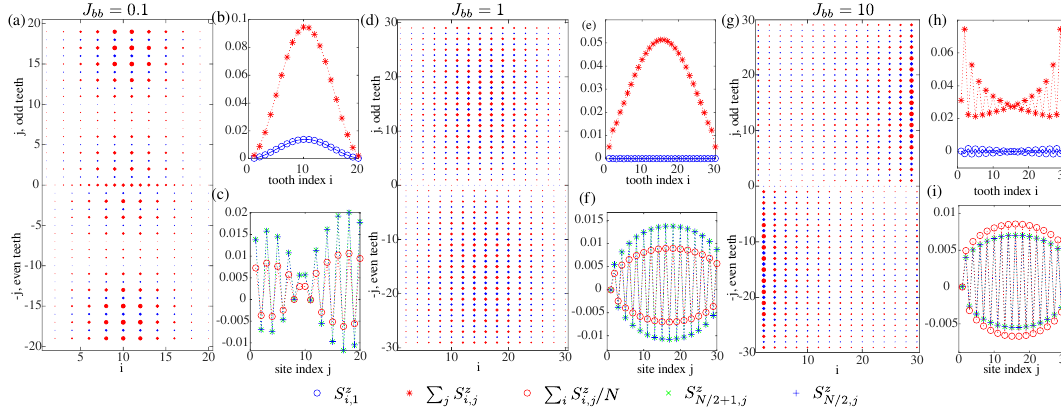
Figure 11: (Color online) Local magnetization profile on combs with even L , N for = 0.1 and L = N = 20; three different values of backbone interaction: (a)-(c) J bb = 1 and L = N = 30; (g)-(i) J = 10 and L = N = 30 . In (a),(d),(g) the (d)-(f) J bb bb comb is unfolded as in Fig.9; backbone sites are placed at the coordinates ( i , j = 0 ) ; the radius of circles is proportional to the absolute value of local magnetization; red and blue colors indicate positive and negative sign of magnetization. Panels (b),(e),(h) show local magnetization on the backbone (blue circles) and total mag- netization of teeth (red stars). Panels (c),(f),(i) show local magnetization along two consecutive teeth in the middle of a comb (green and blue crosses), and average magnetization profile along the teeth (red circles) with a pronounced butterfly profile of local magnetization shown in Fig.14(b). Importantly, the location of the maximum (or minimum) of magnetization on different teeth is